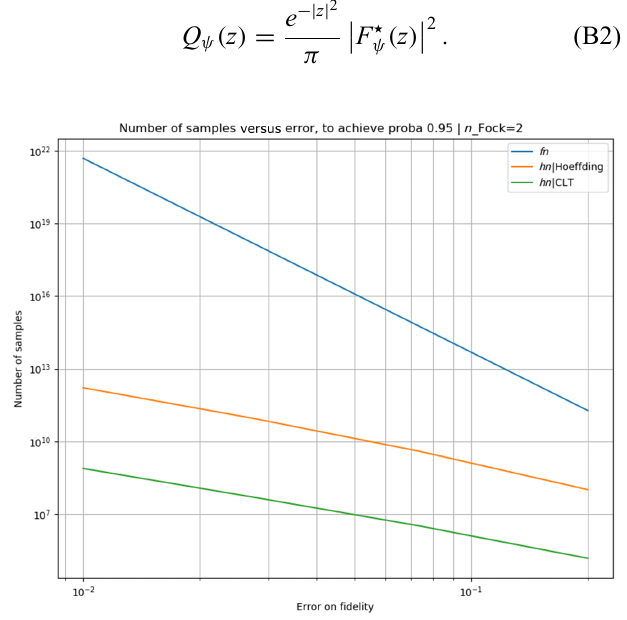
FIG. 6. Efficiency of the various estimation methods for a tar- get Fock state | 2 (cid:3) . The curves represent the number of samples necessary to obtain a given precision on the fidelity estimate with 95% confidence. The top curve is obtained using the protocol from Ref. [32], the middle one using the optimized protocol with analytical bounds, and the bottom one using the improved bounds from the CLT (for which a Fock state | 2 (cid:3) is